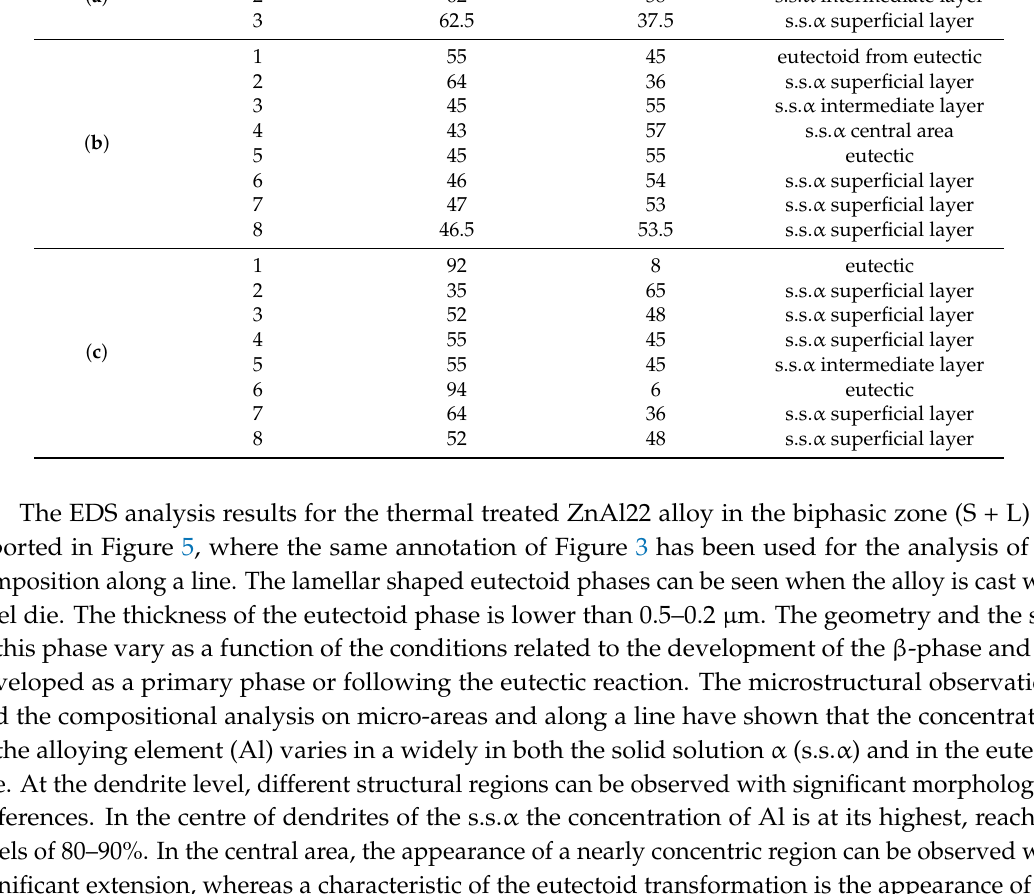
( b ) Figure 6. The alloy structure after the annealing performed during: ( a ) Dilatometric (DIL) and ( b ) Differential Scanning Calorimetry (DSC) analysis. It is very important to mention that, contrary to some scientific literature [25–27], the monophasic structure developed only from the β-phase and shows higher stability at room temperature, a stability which continues for some years (about four years). Since the eutectic and eutectoid transformations play an important role in the development of the final structure, DSC and DIL analyses have been carried out to obtain some information concerning the transformation. This was done using small samples extracted from the castings